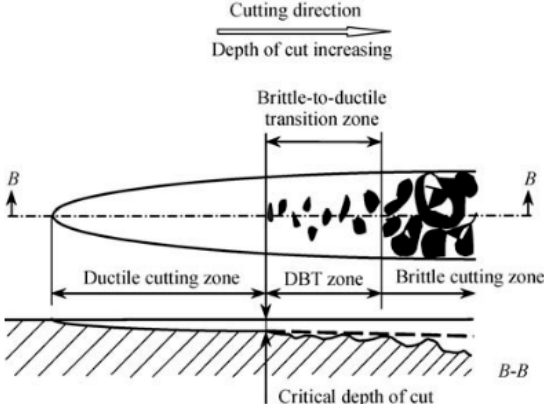
Figure 14. A schematic diagram showing brittle-ductile transition phases. Reproduced with permission from [78]. Springer Nature, 2004.